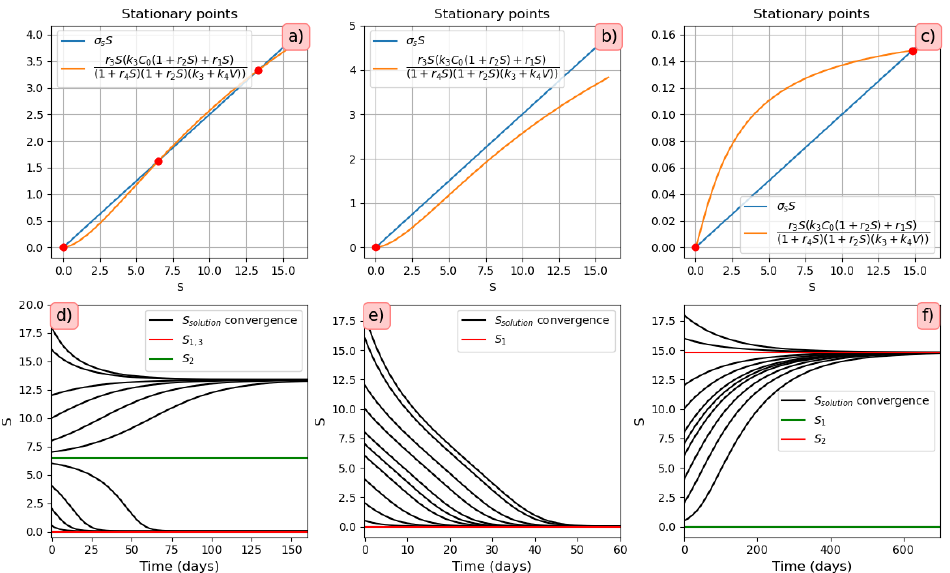
Figure 9. Graphical solutions of Equation (32) with V = 0, p ( V , I ) = 0 and the values of parameters ( a ) r 1 = 3, r 2 = 0.1, r 3 = 1, r 4 = 0.1, σ S = 0.25; ( b ) r 1 = 3, r 2 = 0.1, r 3 = 1, r 4 = 0.1, σ S = 0.3; ( c ) r 1 = 1.4, r 2 = 0.8, r 3 = 1, r 4 = 0.5, σ S = 0.01. Figures ( d ), ( e ) and ( f ) show the convergence to the stable stationary points ( a ), ( b ) and ( c ), respectively.